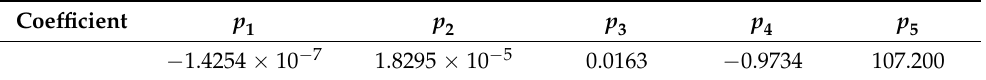
Table 5. Empirical formula coefficient of P − M a characteristic